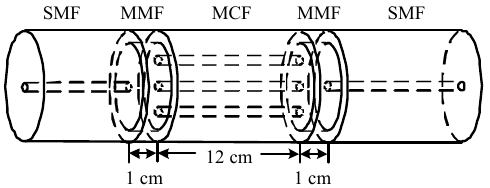
Fig. 5 SMF-MMF-MCF-MMF-SMF